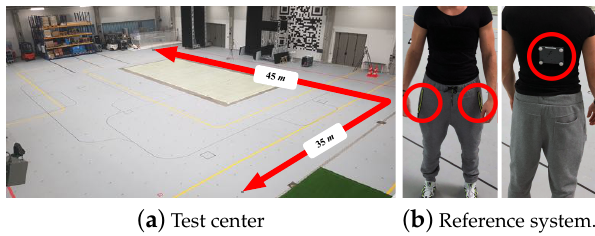
Figure 6. Setup.( a ): lateral view of the data acquisition environment; ( b ): smartphones in the pockets of a trial subject and trackable object of the reference